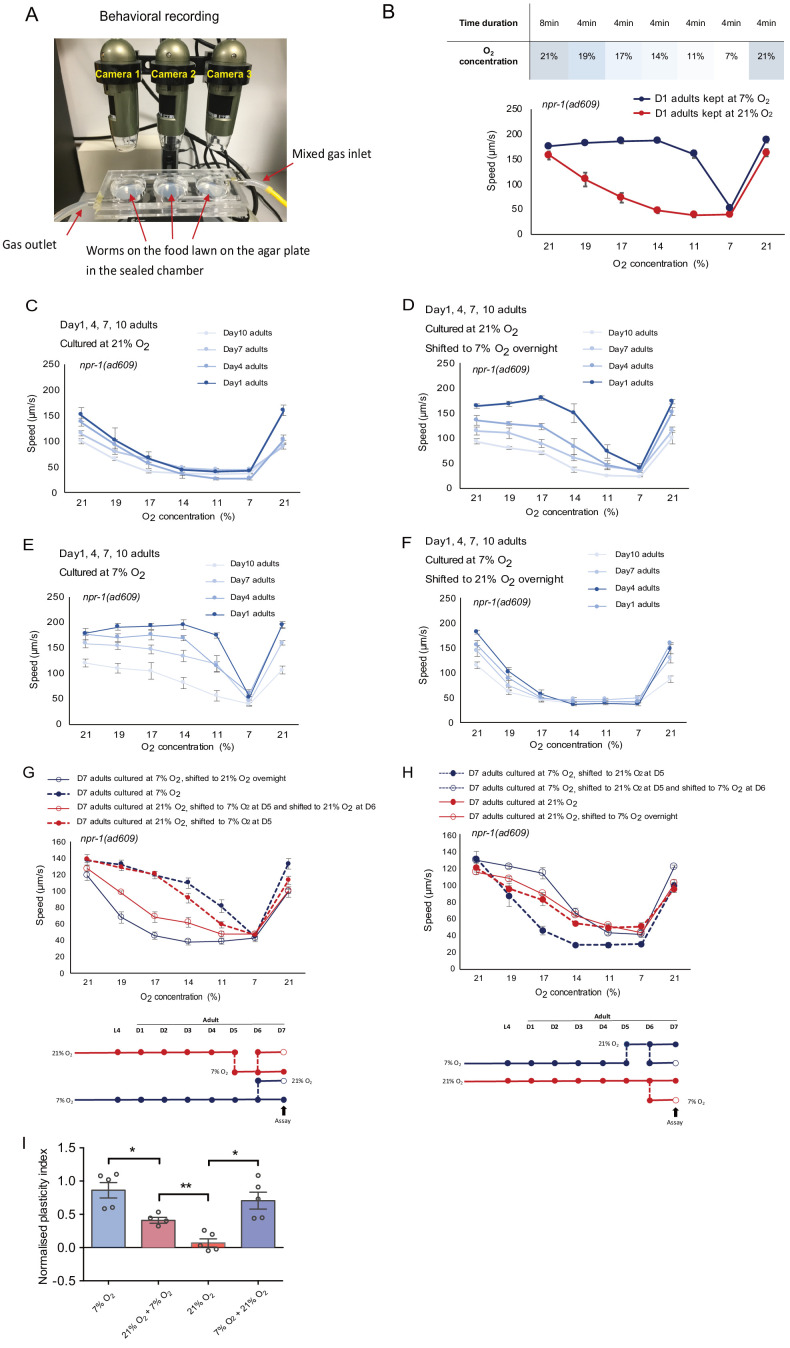
Behavioral assay program, O2-evoked speed responses during ageing, and assay paradigm validation.(A) Behavioral assay set-up. Three cameras are located above each of the assay plates. During the assay, the chamber was sealed and mixed gas was pumped in at a steady flow rate. Worms were placed on the seeded low peptone plates inside the chamber. (B) Assay program for testing worms’ O2-evoked speed responses of 21% and 7% O2 cultured day 1 adults. A full round assay lasts for 32 min. Specifically, the program is set as 8 min of 21% O2, followed by 19%, 17%, 14%, 11%, 7%, 21% O2 for 4 min at each step. (C–E) O2-evoked speed responses gradually decline with age for animals cultured at 21% O2 throughout (C), or shifted to 7% O2 overnight (D), and animals cultured at 7% O2 throughout (E), or shifted to 21% O2 overnight (F). Mean ±sem, three or more assays were performed for each condition. (G and H) O2-evoked speed responses of day seven adults cultured at 21% and 7% O2 and shifted from 7% to 21% O2 (G) or shifting from 21% to 7% O2 (H). Mean ±sem, five or more assays were performed for each condition. (I) Plasticity of day 7 adults cultured at 7% O2 is significantly higher than animals cultured at 21% O2 after shifting from 7% to 21% O2 or shifting from 21% to 7% O2. Mean ±sem, *p<0.05, **p<0.01, unpaired t-test.